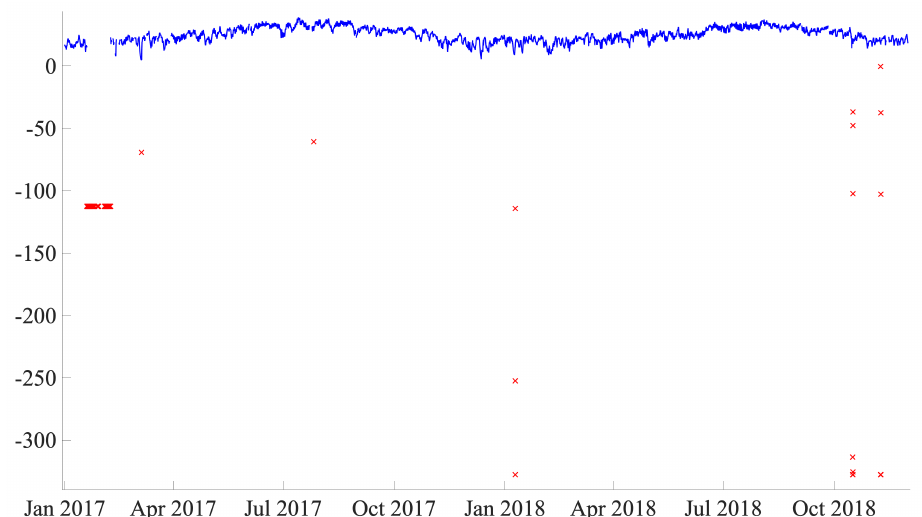
Figure 10. Out-of-range values are detected as outliers (red crosses) and assigned as missing values from the raw signal.